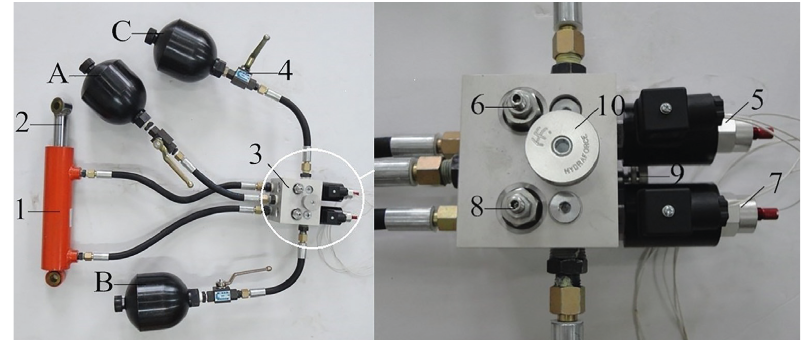
Figure 1: Physical structure of the front axle hydropneumatic suspension